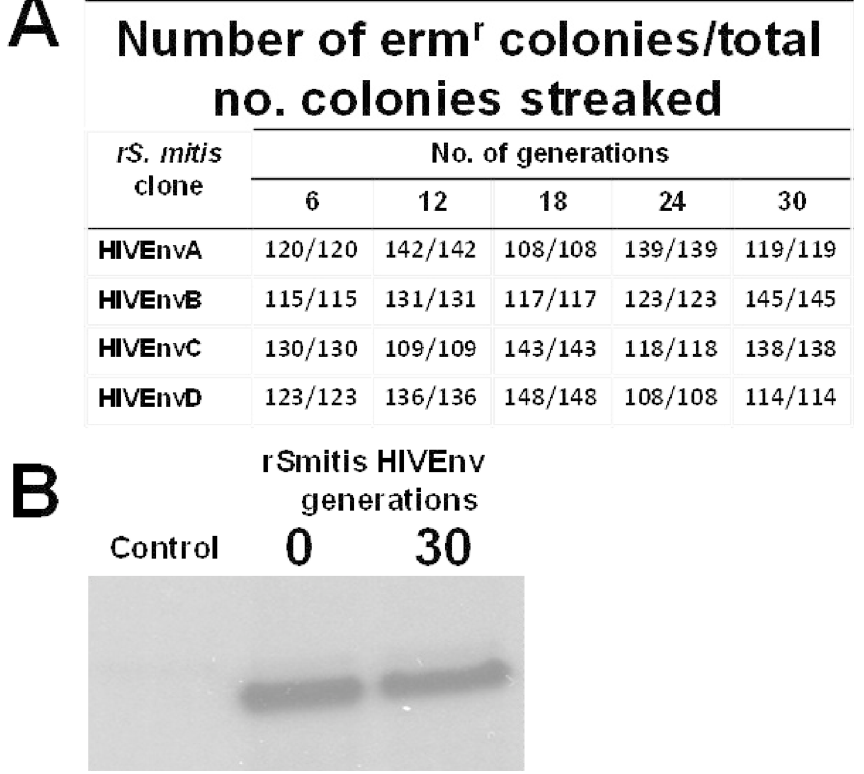
Fig 3. rS . mitis expressing HIV Env is stable. To determine the stability of the integrated Env gp120 gene in rS . mitis , four clones (HIVEnvA, B, C, and D) were picked at random and grown anaerobically for 24 hours which represents approximately three generations (7.1 hours per generation) in THB media without erythromycin. Cultures were grown for approximately 30 generations without erythromycin. From each generation 100 and 150 colonies were picked at random and streaked to THB plates with and without erythromycin. For each S . mitis HIV Env clone, the number of Erm r colonies/total number of colonies streaked after 6, 12, 18, 24, and 30 generations was determined (Fig 3A). Expression of Env in the same daughter clones was analyzed by Western blot analysis. Env production in a representative daughter clone (after 30 generations) and the original HIVgp120A clone is shown (Fig